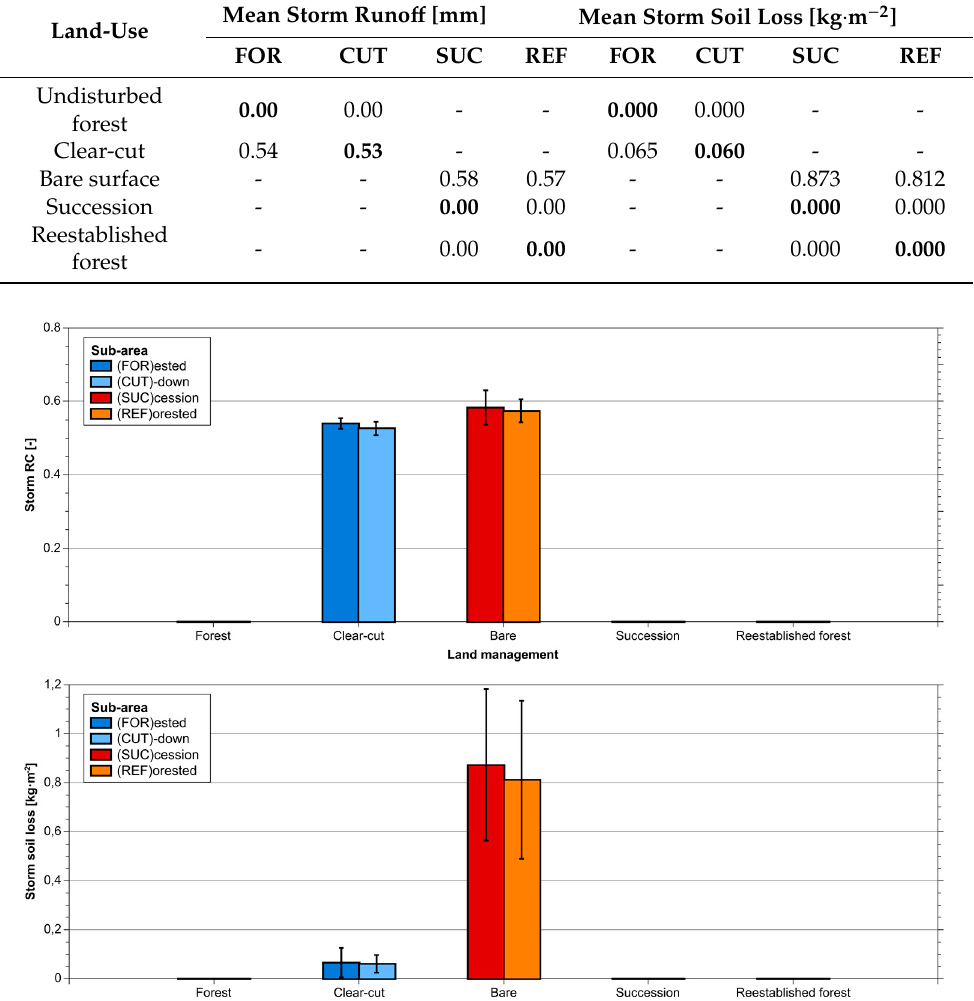
Table 16. Significance ( p ) and effect size ( η 2 ), testing depth- and soil-related influence on RC and sediment loss (Two-way ANOVA for soil categories FOR, CUT, SUC and REF). Significant values appear bold.